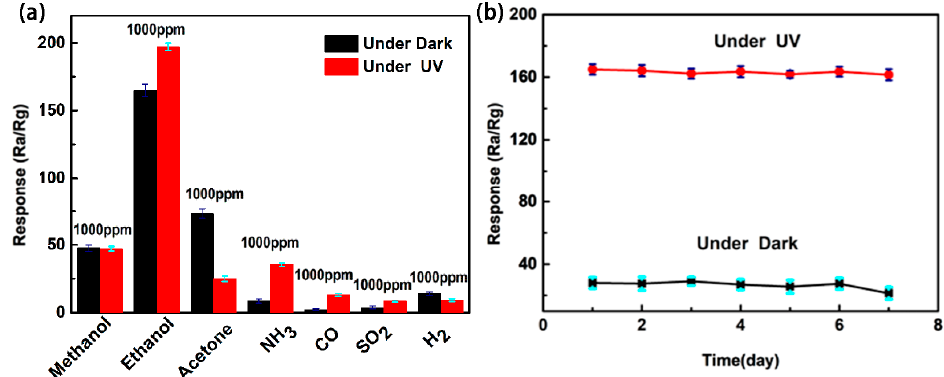
Figure 7. ( a ) Responses to various gases and ( b ) the long-term stability for seven days toward 100 ppm ethanol of the ZnO film sensors under dark and under UV light illumination.